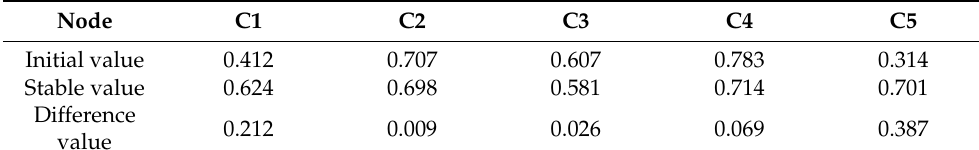
Table 4. Initial and stable values. The initial value is obtained by calculating the initial weight of each factor in Section 2.3.4. The stable value represents the optimal value of the system.